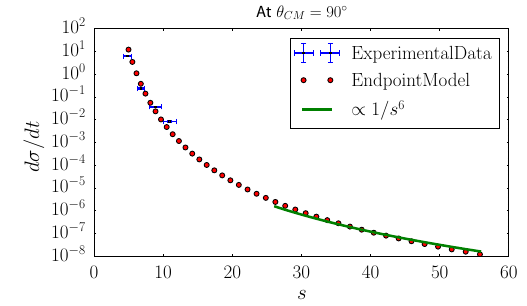
Fig. 3 EP evaluation of d σ/ dt nbarns / GeV 2 vs s GeV 2 for m = 0.11 GeV; v = 41.25, a = 0, t = 38.26 (GeV − 2